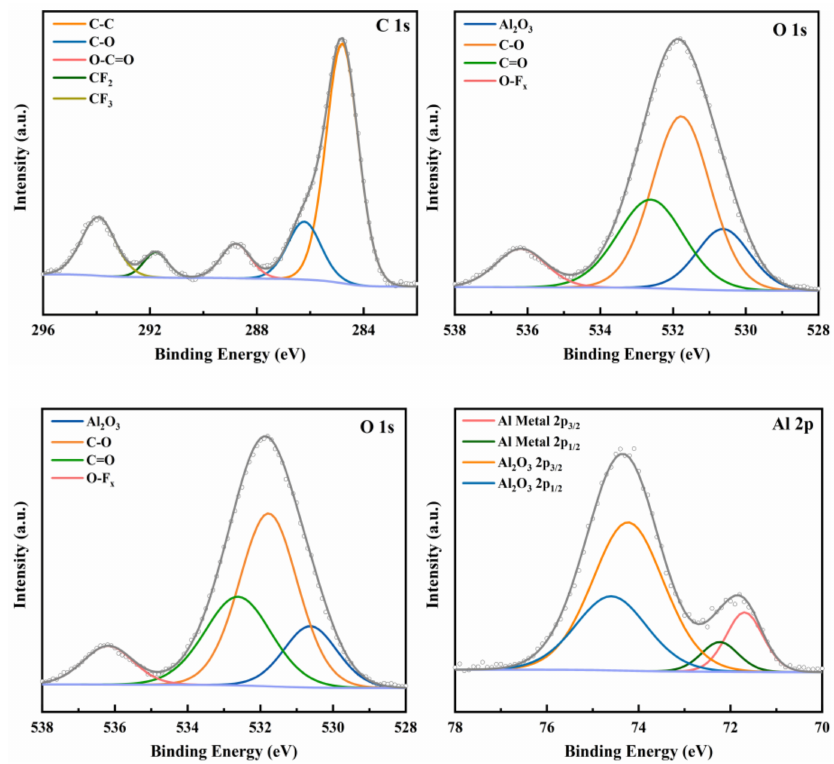
Figure 5. XPS spectra of C 1s peaks, O 1s peaks, F 1s peaks, and Al 2p peaks for nAl@2.5%PFPE